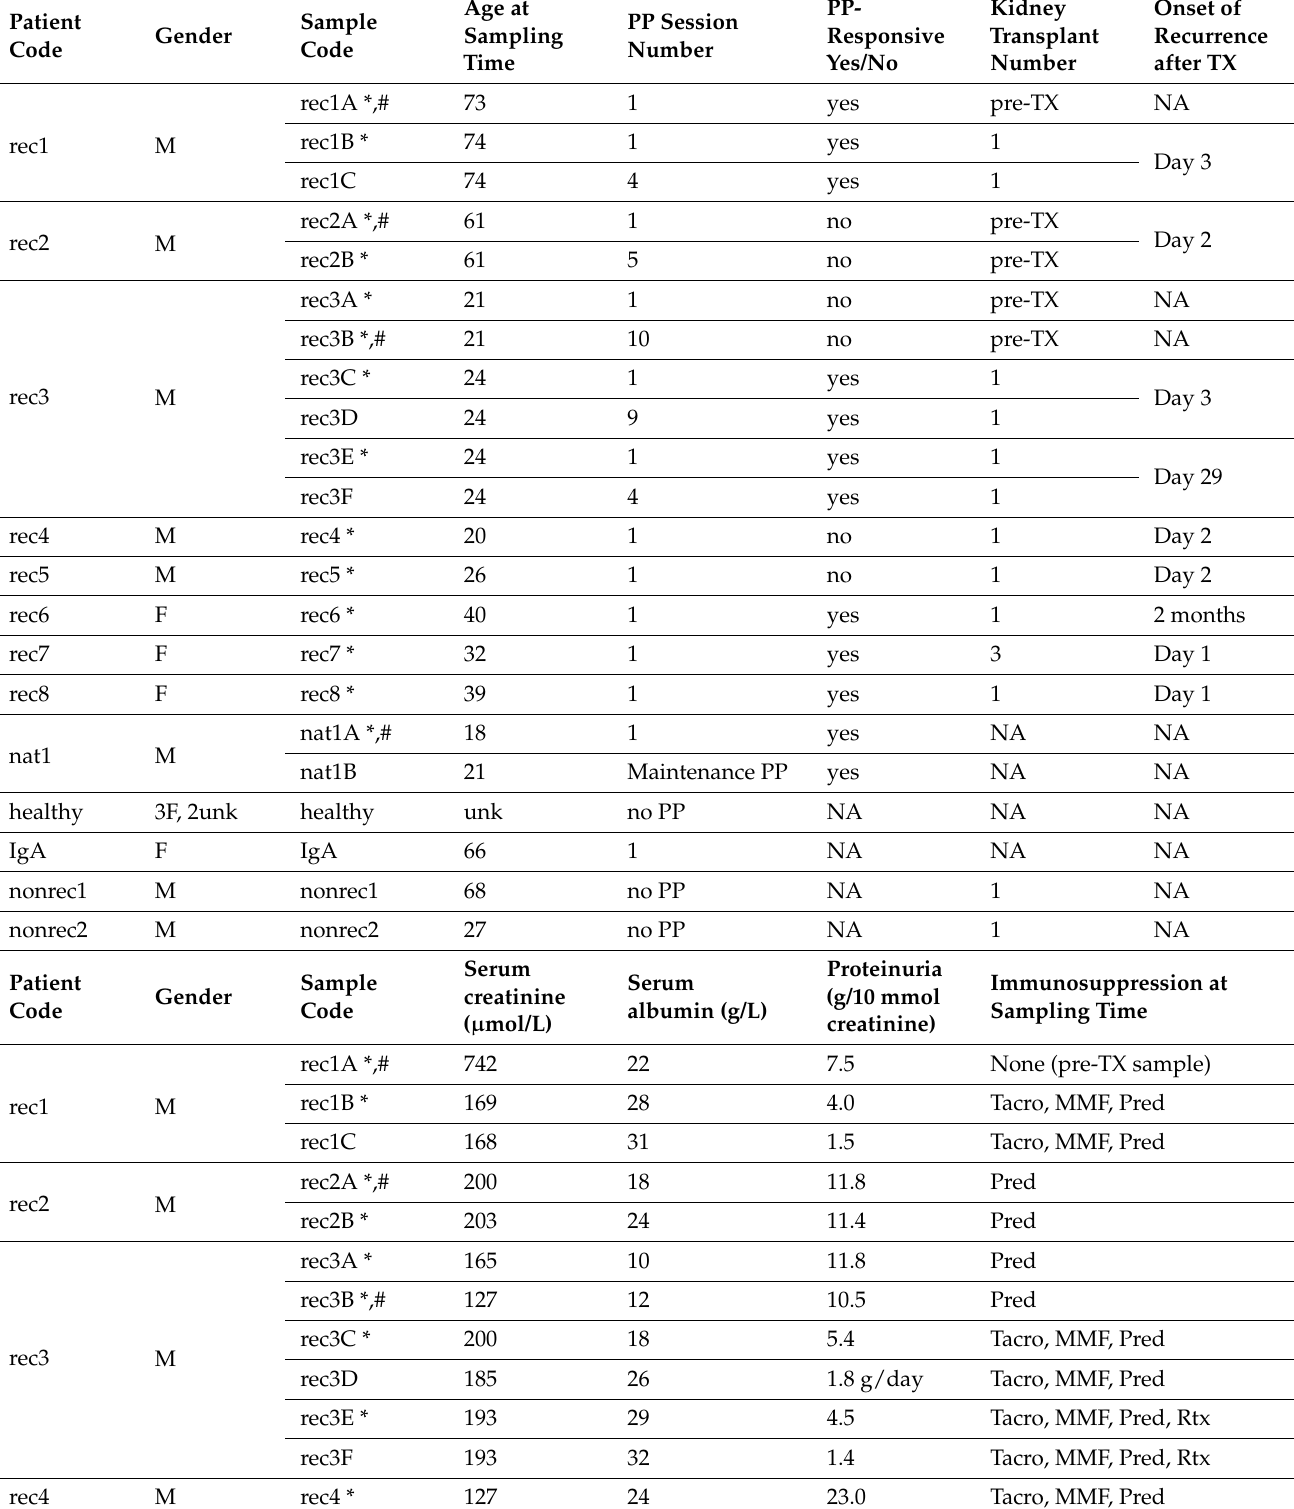
Table 1. Clinical characteristics of patients and (disease) controls used for